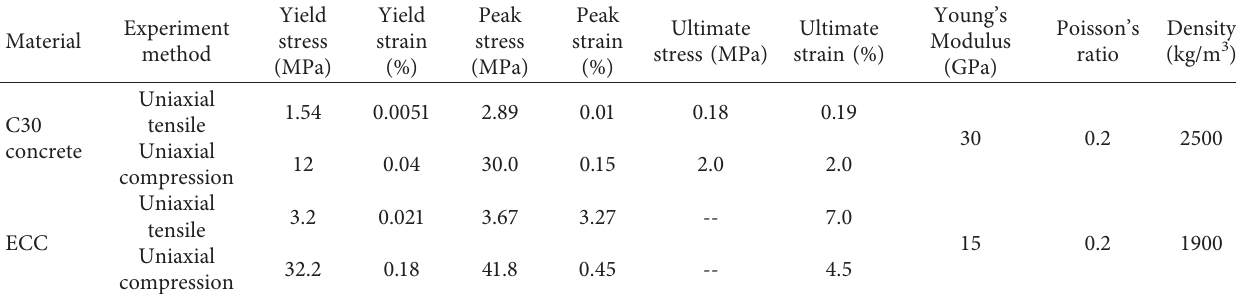
Figure 3: Constitutive model curves of the ECC and concrete materials. (a) Tensile stress-strain curves. (b) Compression stress-strain curves. Table 1: Physical and mechanical parameters of the ECC and concrete materials.